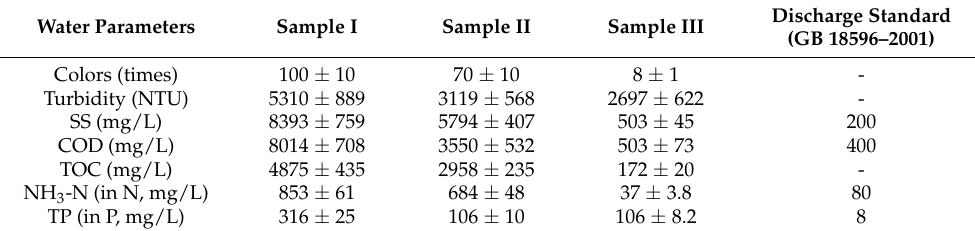
Table 1. Characterization of swine wastewater